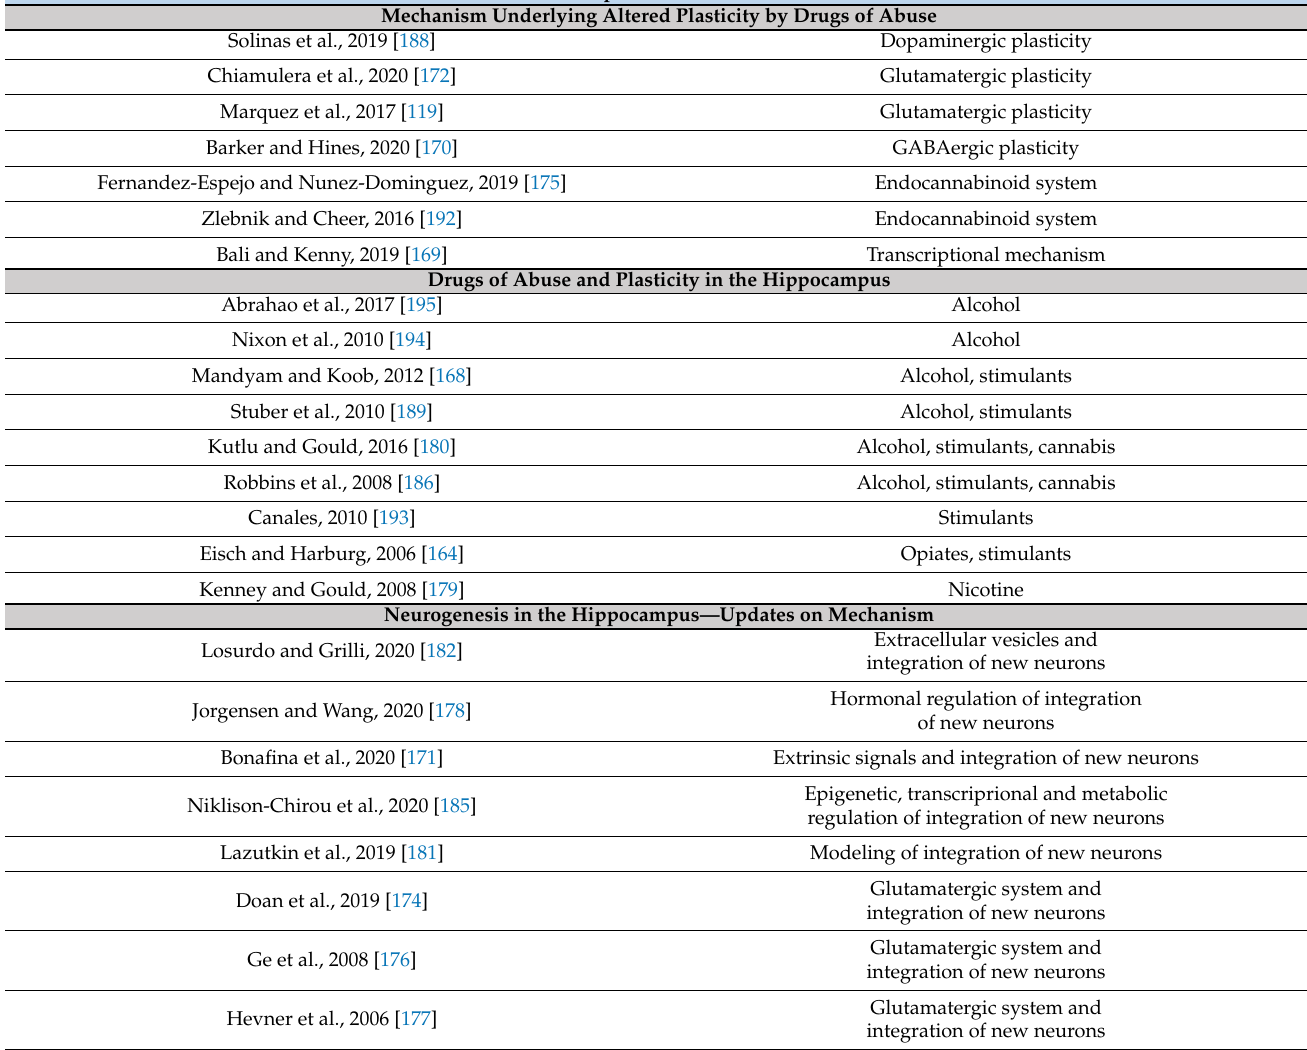
Table 1. Summarizes a list of review manuscripts on each of the topics/subtopics covered in the manuscript. The authors recommend these review articles for additional information on each subtopic indicated